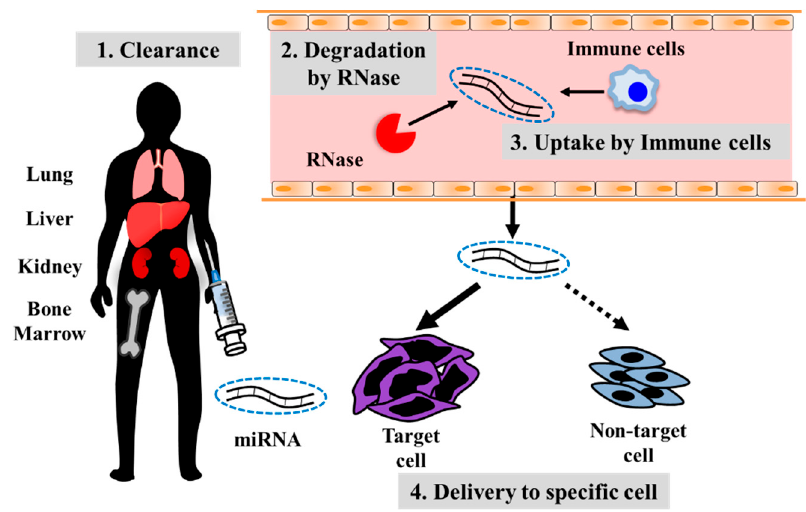
Figure 2. Challenges for miRNA ‐ based cancer therapy development.